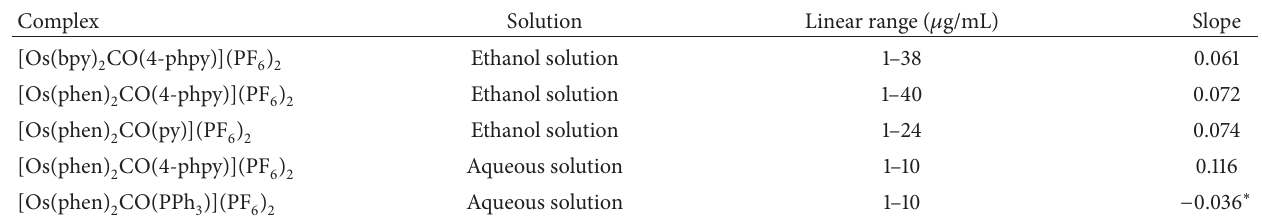
curves to heparin of the three osmium complexes. 0